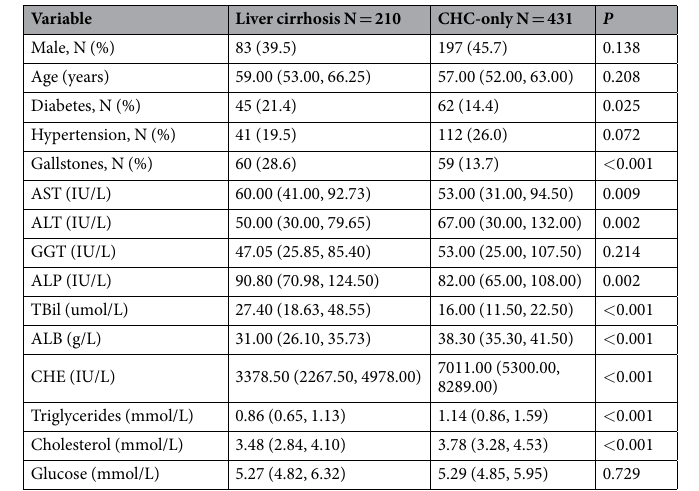
Table 1. Demographic and clinical characteristics of cases and controls. Continuous variables are expressed as median (25th, 75th percentiles). Categorical variables are displayed as numbers and percentages. AST = aspartate aminotransferase, ALT = alanine aminotransferase, ALP = alkaline phosphatase, GGT = gamma-glutamyl transpeptidase, TBil = total bilirubin, ALB = albumin, CHE = cholinesterase, CHC = chronic hepatitis